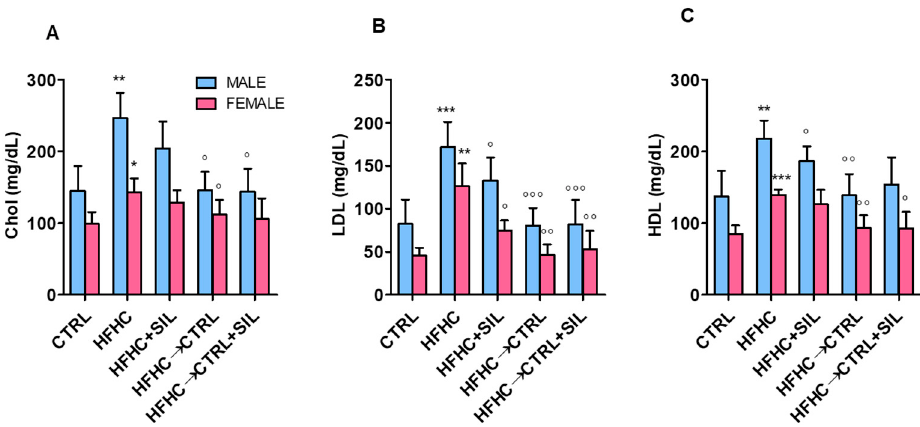
Figure 1. Effect of silymarin-containing food on the lipid profile. The amount of ( A ) total cholesterol; ( B ) LDL cholesterol; and ( C ) HDL cholesterol was measured in all the experimental groups. * p < 0.05 vs. CTRL; ** p < 0.01 vs. CTRL; *** p < 0.001 vs. CTRL and ◦ p < 0.05 vs. HFHC; ◦◦ p < 0.01 vs. HFHC; ◦◦◦ p < 0.001 vs.